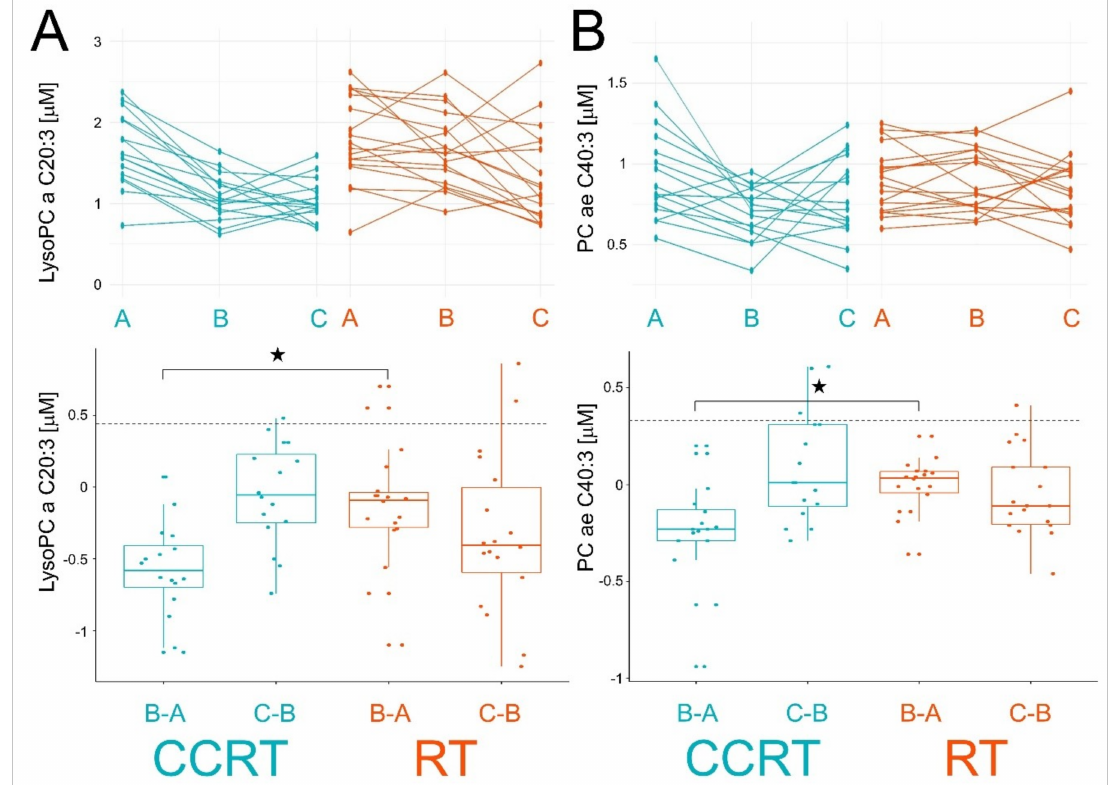
Figure 4. Individual changes in levels of lysoPC a C20:3 (Panel A) and PC ae C40:3 (Panel B) between consecutive samples. Showed are time courses of individual levels (upper graphs; samples A, B, and C) and di ff erences between consecutive samples (bottom graphs; changes B-A and C-B). Boxplots show minimum, lower quartile, median, upper quartile, and maximum values; dots represent individual di ff erences; significant change (FDR < 0.05) is marked with asterisks. CCRT samples are marked in blue and RT samples are marked in